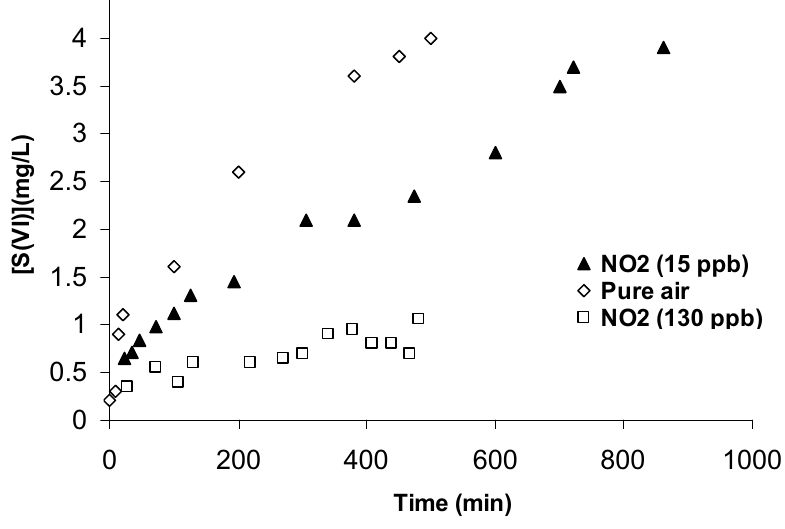
Fig. 2a – Time dependence of [S(VI)] for S(IV) oxidation, [S(IV)] ◦ = 8 mg/L, pH = 5.2, T = 22 ◦